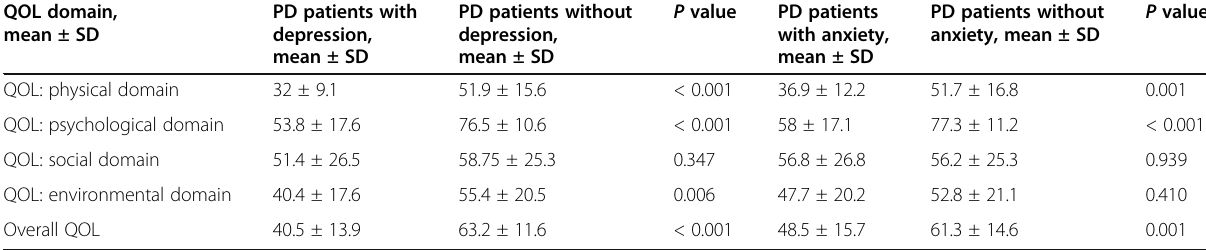
Table 7 Impact of depression and anxiety in Parkinson ’ s disease patients on quality of life QOL domain, mean ± SD